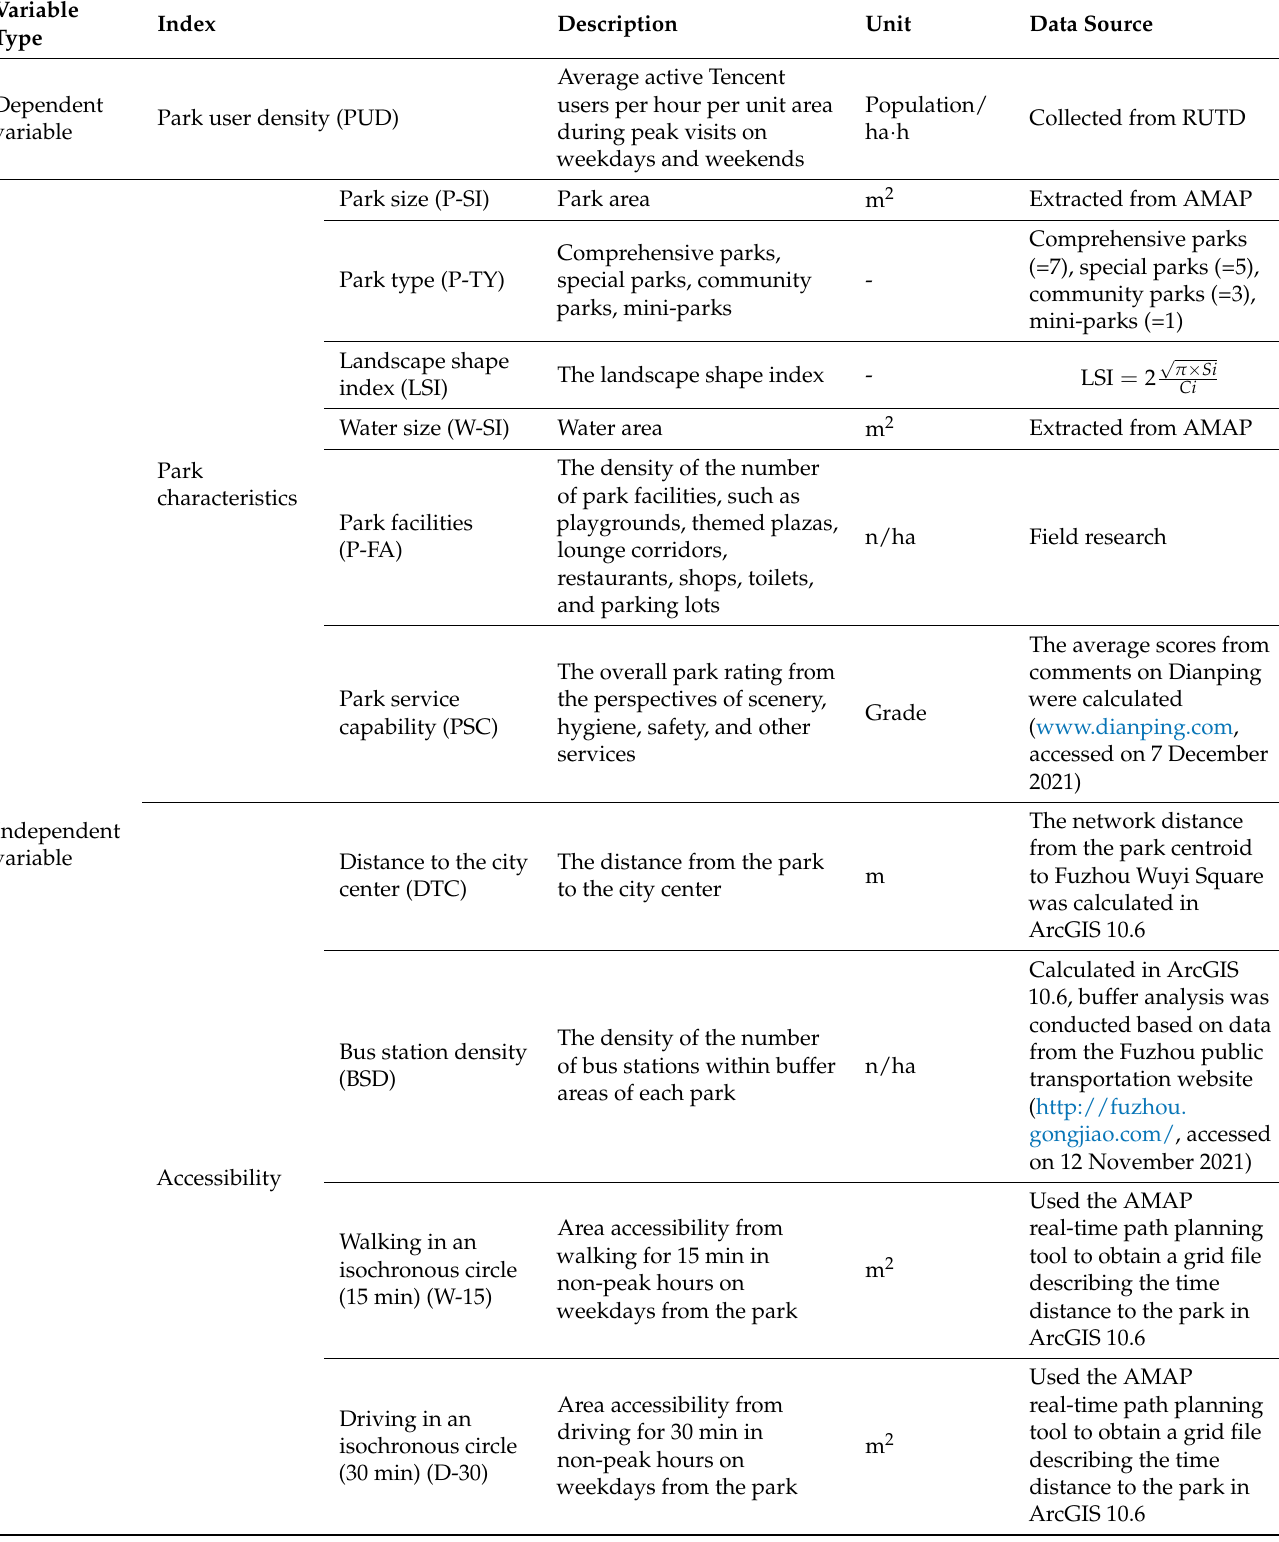
Table 1. Variables: description and data